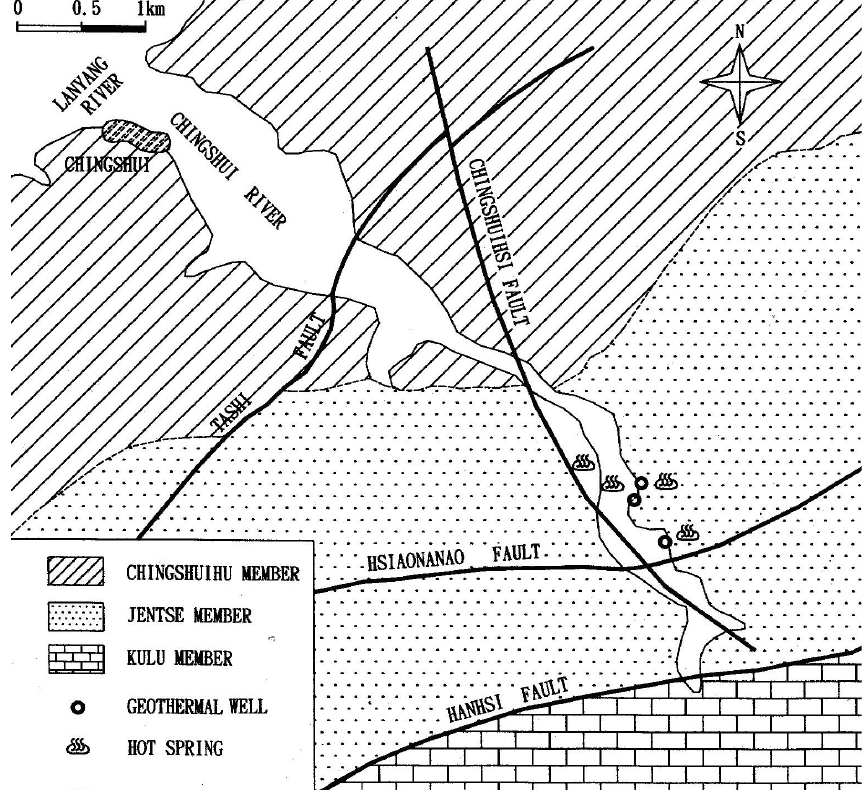
Fig. 3. Geological map of the Chingshui geothermal area describing Chingshuihu, Jentse, and Kulu members of the Miocene Lushan Formation (Su, 1978; Hsiao and Chiang,